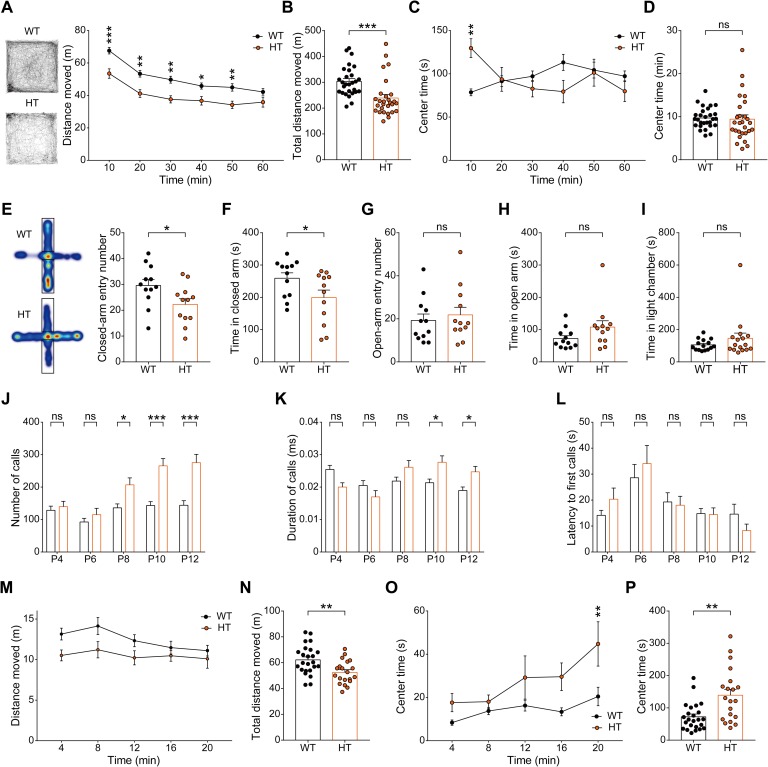
Adult and juvenile Grin2b+/C456Y mice display hypoactivity and anxiolytic-like behavior, whereas Grin2b+/C456Y pups show anxiety-like enhanced USVs upon mother separation.(A–D) Hypoactivity, but normal anxiety-like behavior, in Grin2b+/C456Y mice (P68–78) in the open-field test, as shown by distance moved and time spent in the center region of the open-field arena. n = 28 mice for WT and HT, *P < 0.05, **P < 0.01, ***P < 0.001, two-way ANOVA with Sidak’s test and Mann-Whitney test. (E–H) Anxiolytic-like behavior in Grin2b+/C456Y mice (P70–124) in the elevated plus-maze, as shown by entries into and time spent in closed/open arms. n = 12 mice for WT and HT, *P < 0.05, Student t test (time in closed arms and closed-arm entry number) and Mann-Whitney test (time in open arms and open-arm entry number). (I) Normal anxiety-like behavior in Grin2b+/C456Y mice (P75) in the light-dark test, as shown by time spent in the light chamber. n = 15 mice for WT and 16 for HT, Mann-Whitney test. (J–L) Grin2b+/C456Y pups (P4–12) emit strongly increased USVs upon mother separation, as shown by the total number of USV calls, duration of each USV calls, and latency to first calls. n = 62 (WT) and 38 (HT), *P < 0.05, ***P < 0.001, two-way ANOVA with Sidak’s test. (M–P) Grin2b+/C456Y juveniles (P19–21) show modest hypoactivity and anxiolytic-like behavior in the open-field test, as shown by distance moved and time spent in the center region of the open-field arena. n = 24 mice for WT and 20 for HT, **P < 0.01, two-way ANOVA with Sidak’s test, Student t test (distance moved) and Mann-Whitney test (center time). The numerical data underlying this figure can be found in S3 Data. HT, heterozygous; ns, not significant; P, postnatal day; USV, ultrasonic vocalization; WT, wild type.